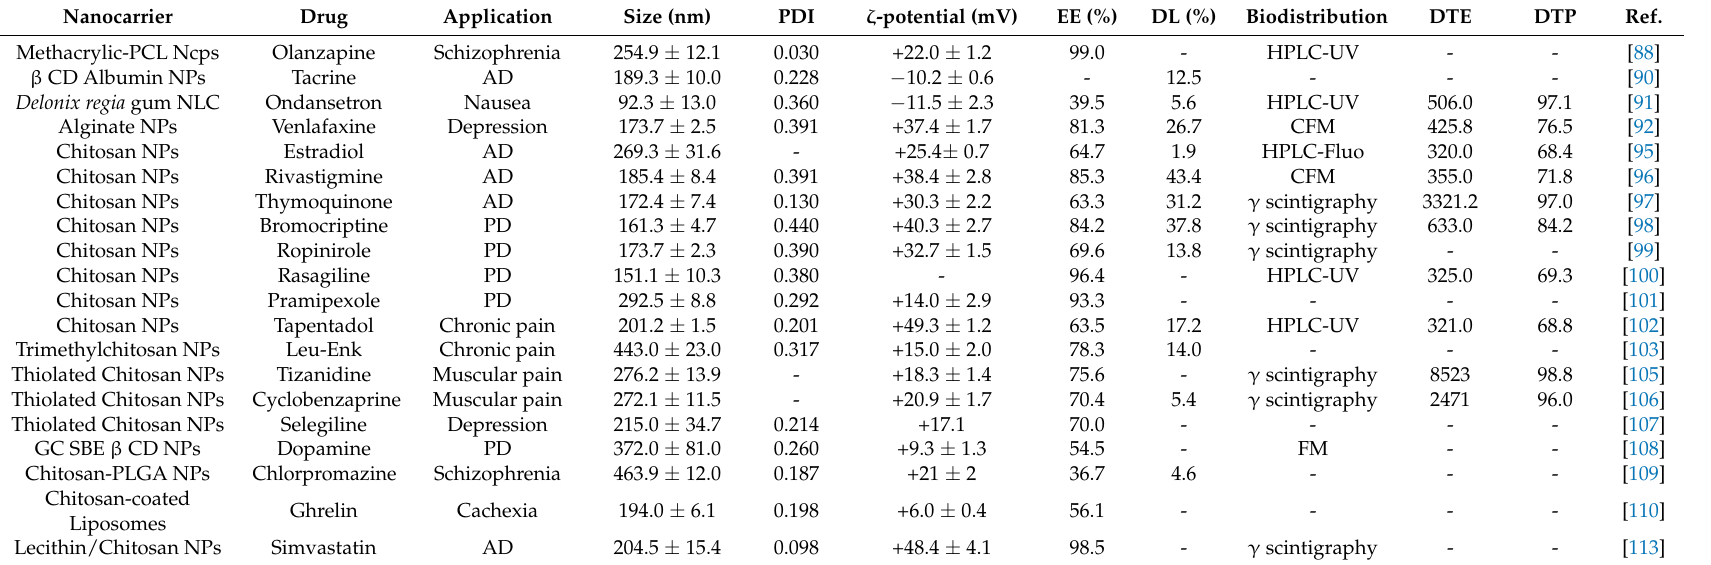
Table 1. Mucoadhesive nanocarriers studied for nose-to-brain